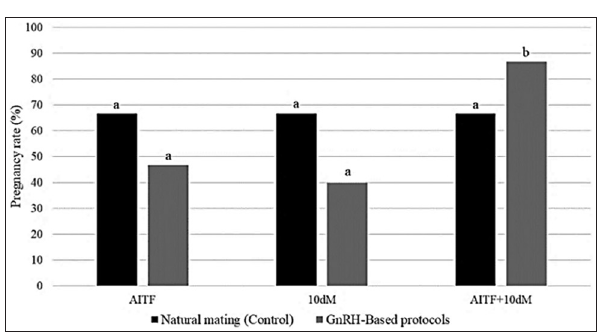
Figure-2: Pregnancy rates in ewes after gonadotropin- releasing hormone (GnRH)-based protocols, cervical fixed- time artificial insemination, and 10-day mating period (Natural mating vs. GnRH-based synchronization). Natural mating=Control group pregnancy rate, GnRH-based protocols=Global pregnancy rates merging Pre-synch and Ovsynch protocols, AITF=Fixed-time artificial insemination, 10-day M=10-day mating period, NP=No pregnant, Total=Total pregnant rates. Different letter indicates a t-test significant difference